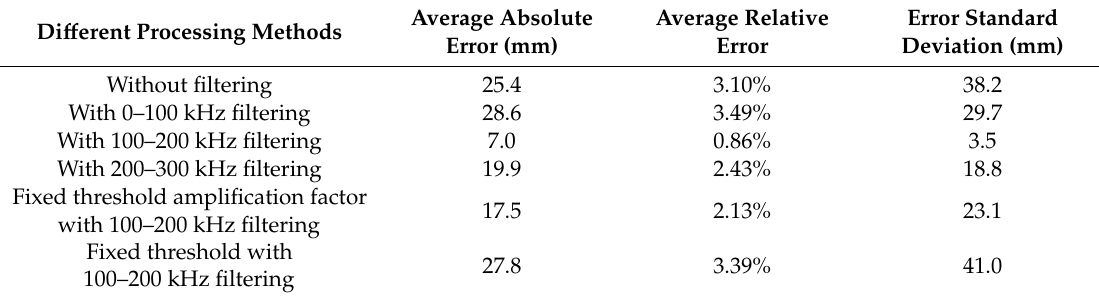
Table 5. The comparison of locating errors under different processing methods.